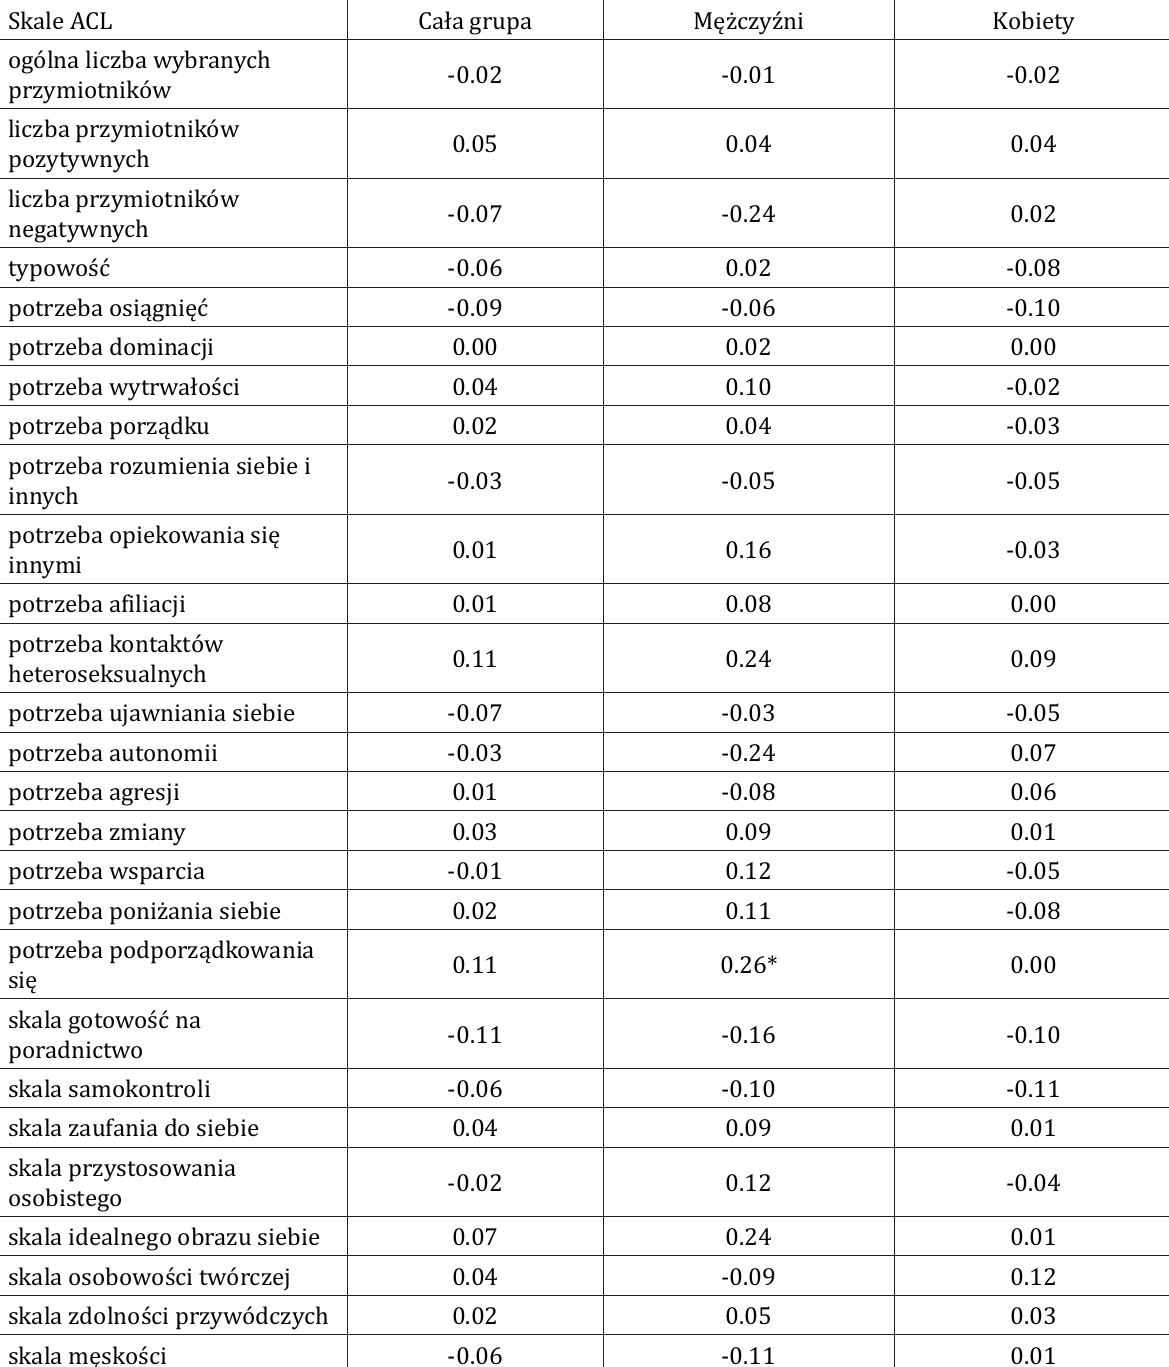
Tabela 2. Współczynniki korelacji między długością czasu spędzanego na portalu społecznościowym a skalami Testu